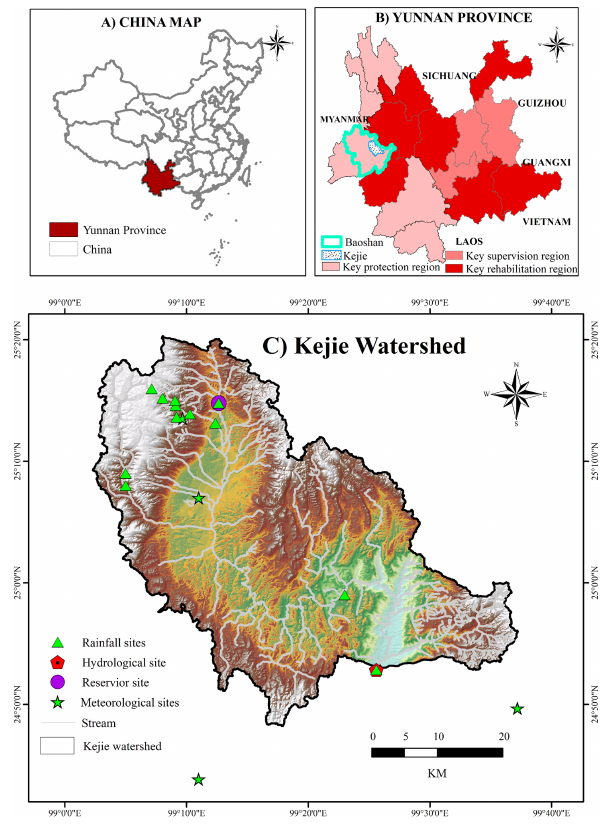
Figure 1. Location map of the Kejie watershed, in Yunnan Province, southwest China, with current erosion classification of the province (Fig. 1b), location of weather and rainfall stations, and catchment